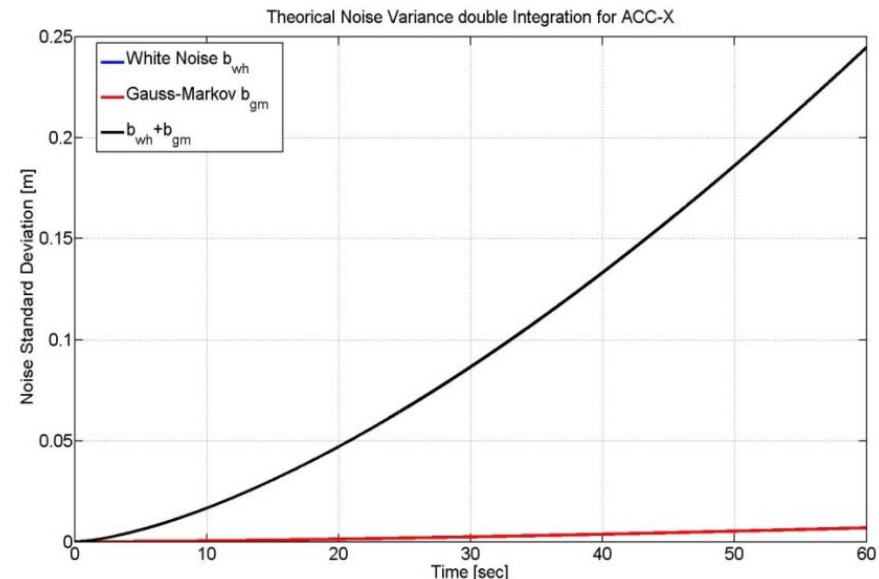
Figure 2. Theoretical Double Integration of different noise sources for a calibrated